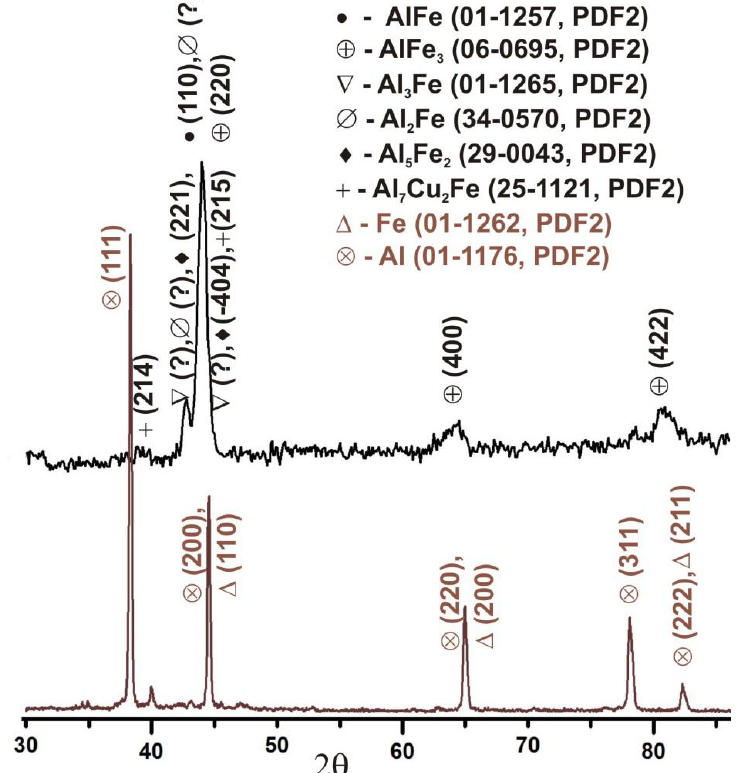
Figure 5. X-ray diffraction patterns of Fe–Al DMD multilayer